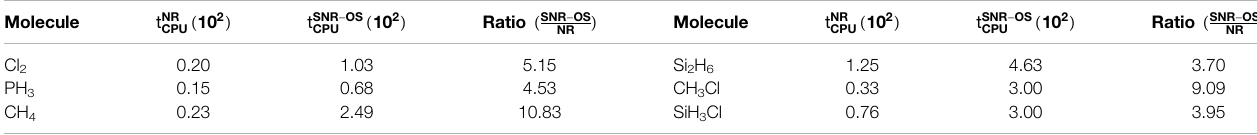
TABLE 6 | Timing (in s) comparison between NR and SNR-OS schemes for one SCF iteration for some representative systems, adopted from Ghosal et al. (2019). Molecule